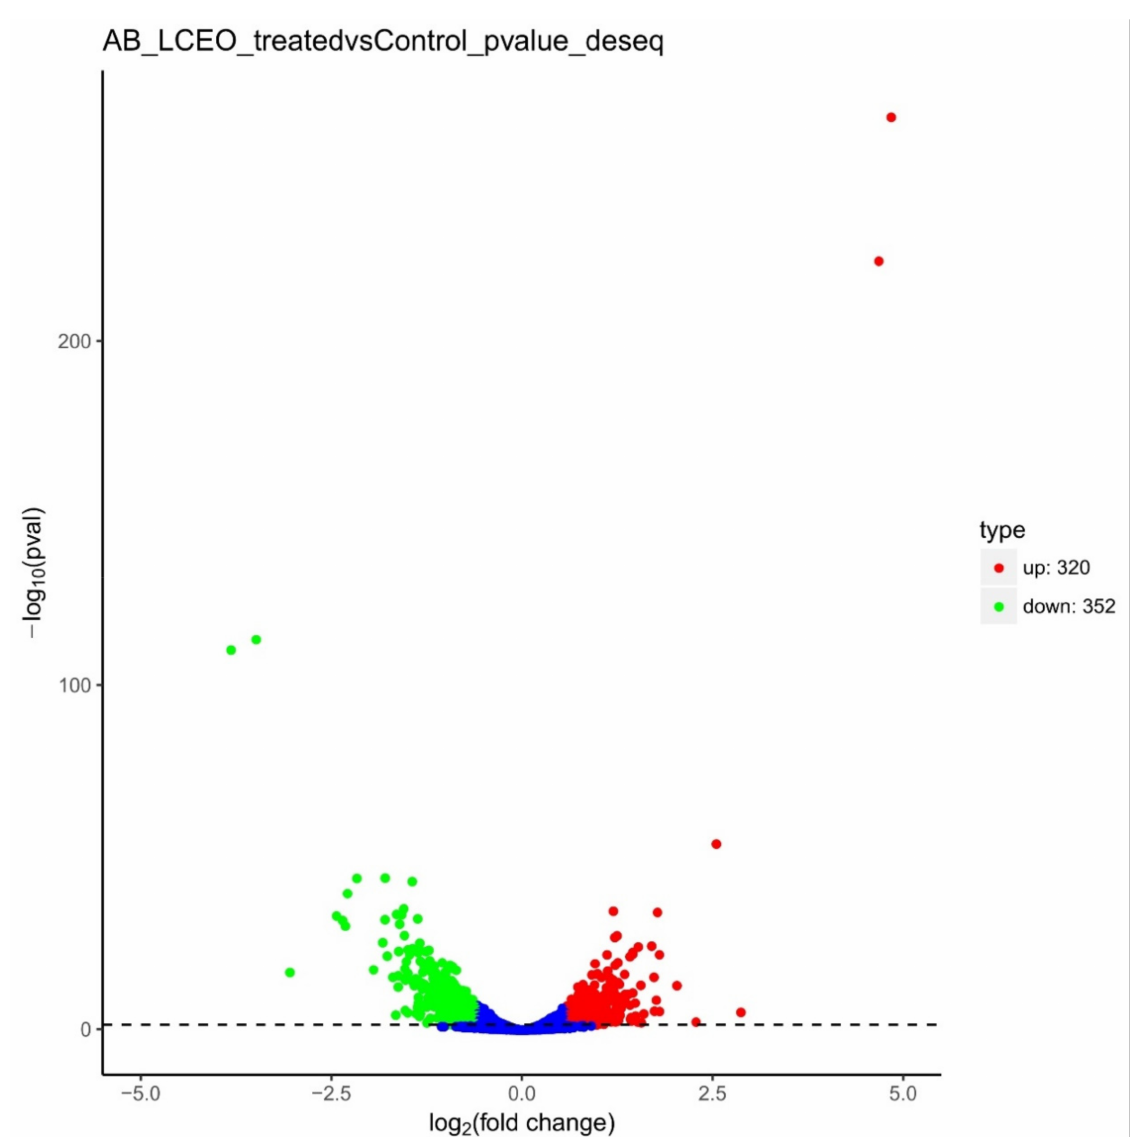
Figure 2. Differential expression level of LCEO-treated (AB_LCEO_treated) and non-treated A. baumannii (Control) groups identified by |fold change| > 1.5 and p -value <